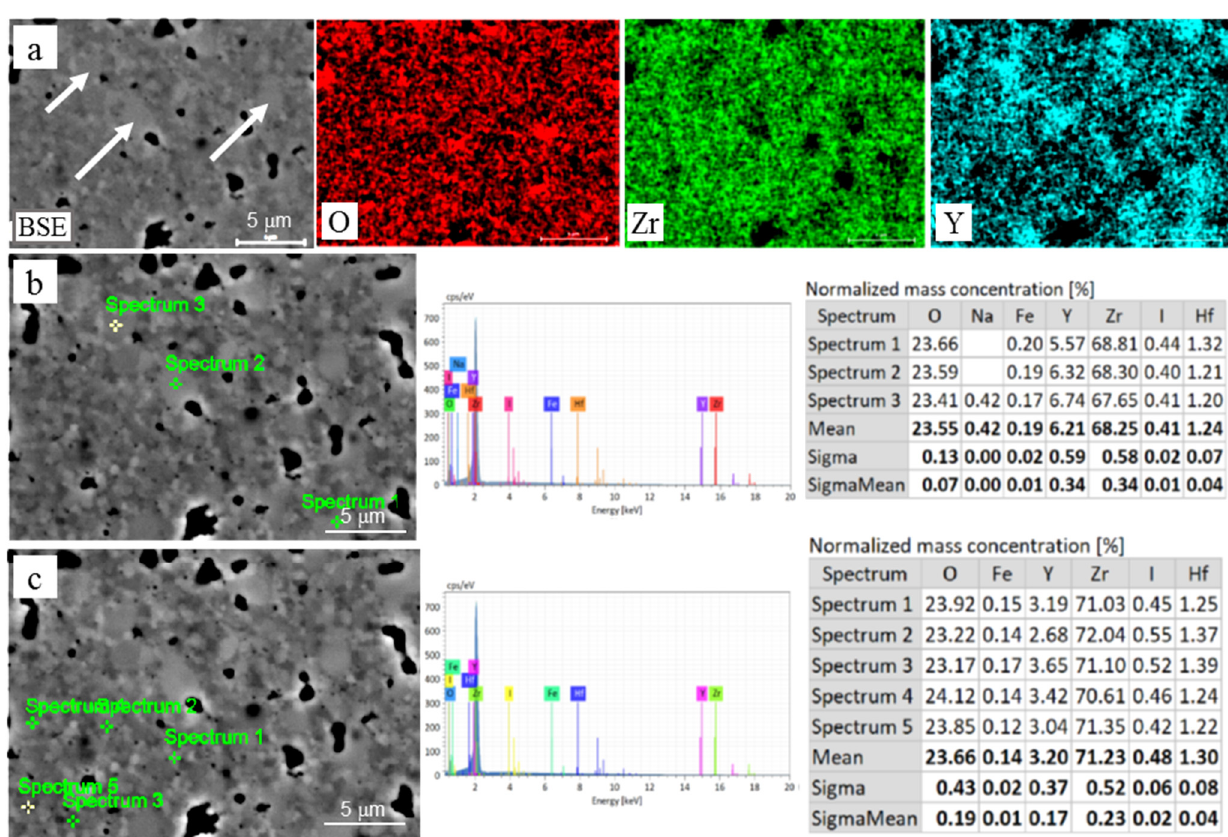
Figure 5. Chemical analysis of 3YSZ material: ( a ) SEM–EDS maps for O, Zr, and Y, showing grains enriched in Y (white arrows); quantitative analysis of ( b ) coarse and ( c ) fine grains with corresponding EDS spectra and concentration